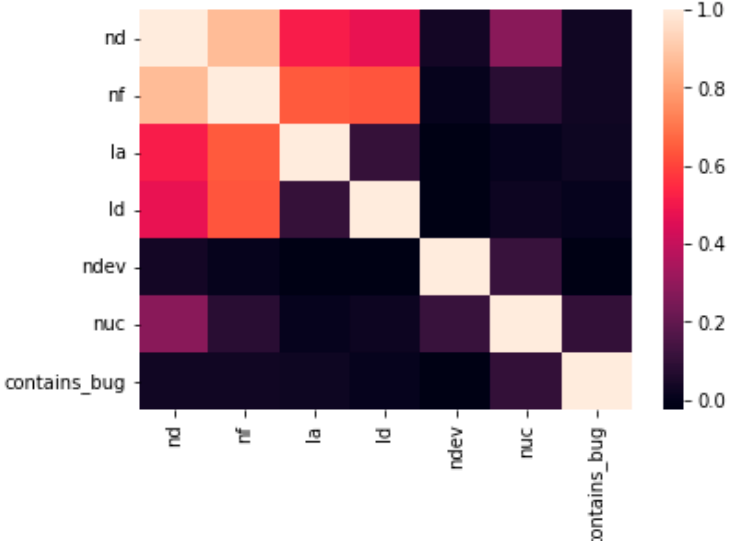
Figure 3. Correlation between features .